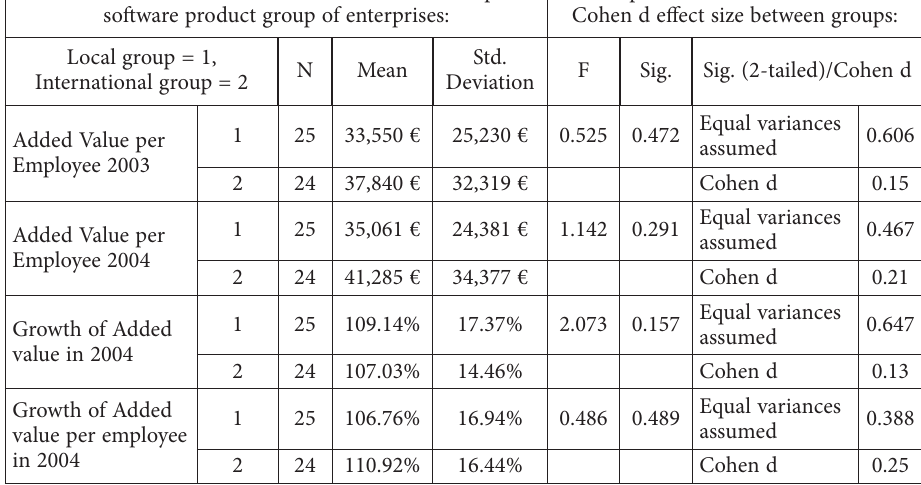
Table 5. The comparison of indicators of IT use and of economic performance between the enterprises that predominantly invest in international and those that predominantly invest in local software products Basic statistics for the international and local enterprise Independent Student’s t-test and software product group of enterprises: Cohen d effect size between